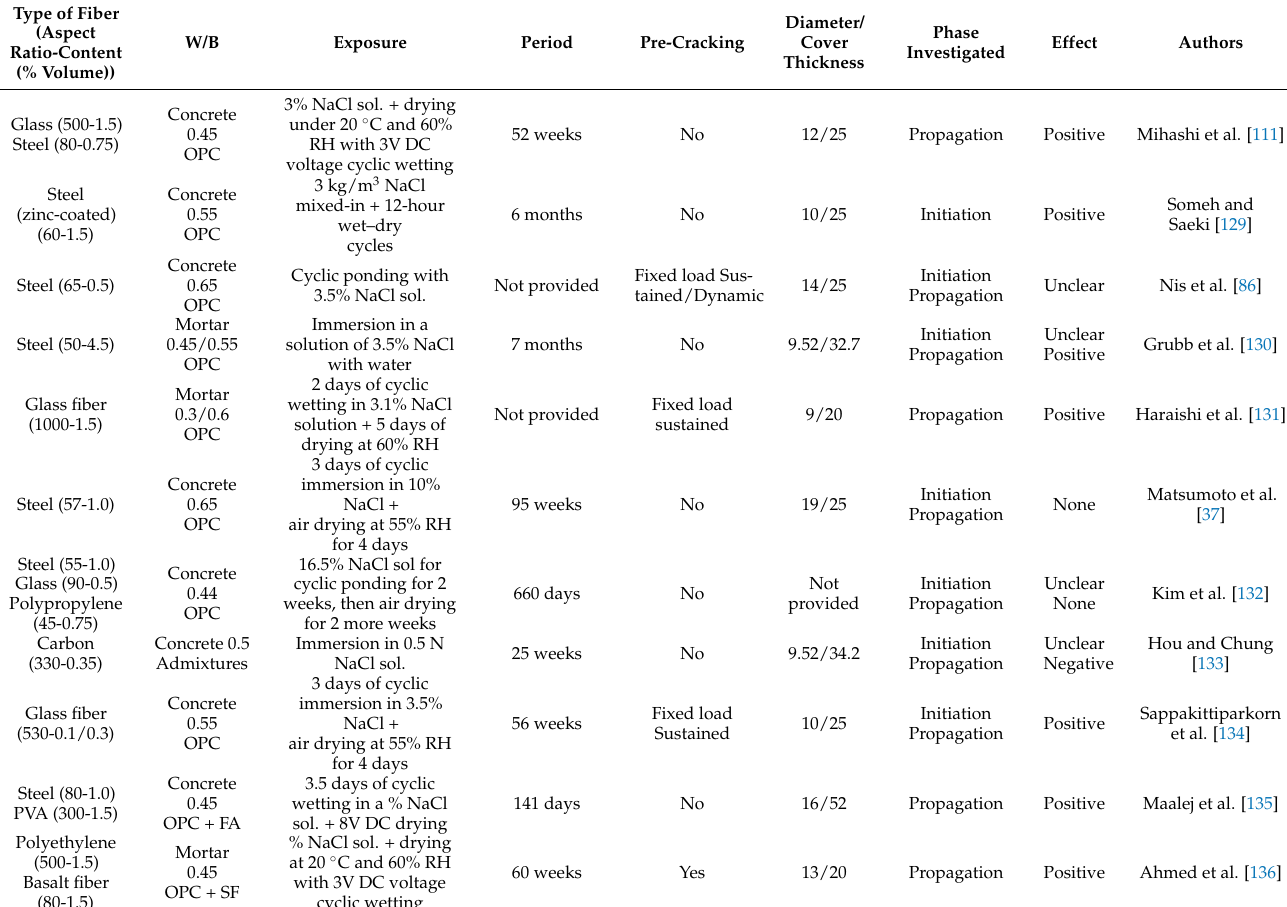
Table 2. An overview of experimental investigations on the corrosion of rebar in fiber-reinforced